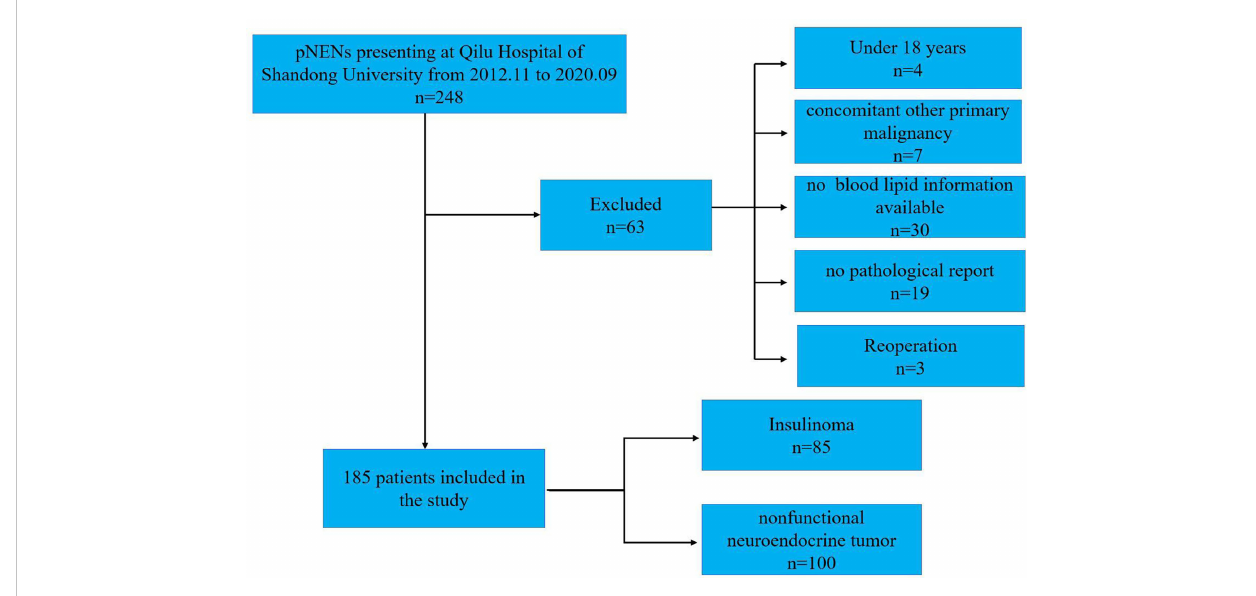
FIGURE 1 Descriptive fl ow chart for inclusion and exclusion of patients in this